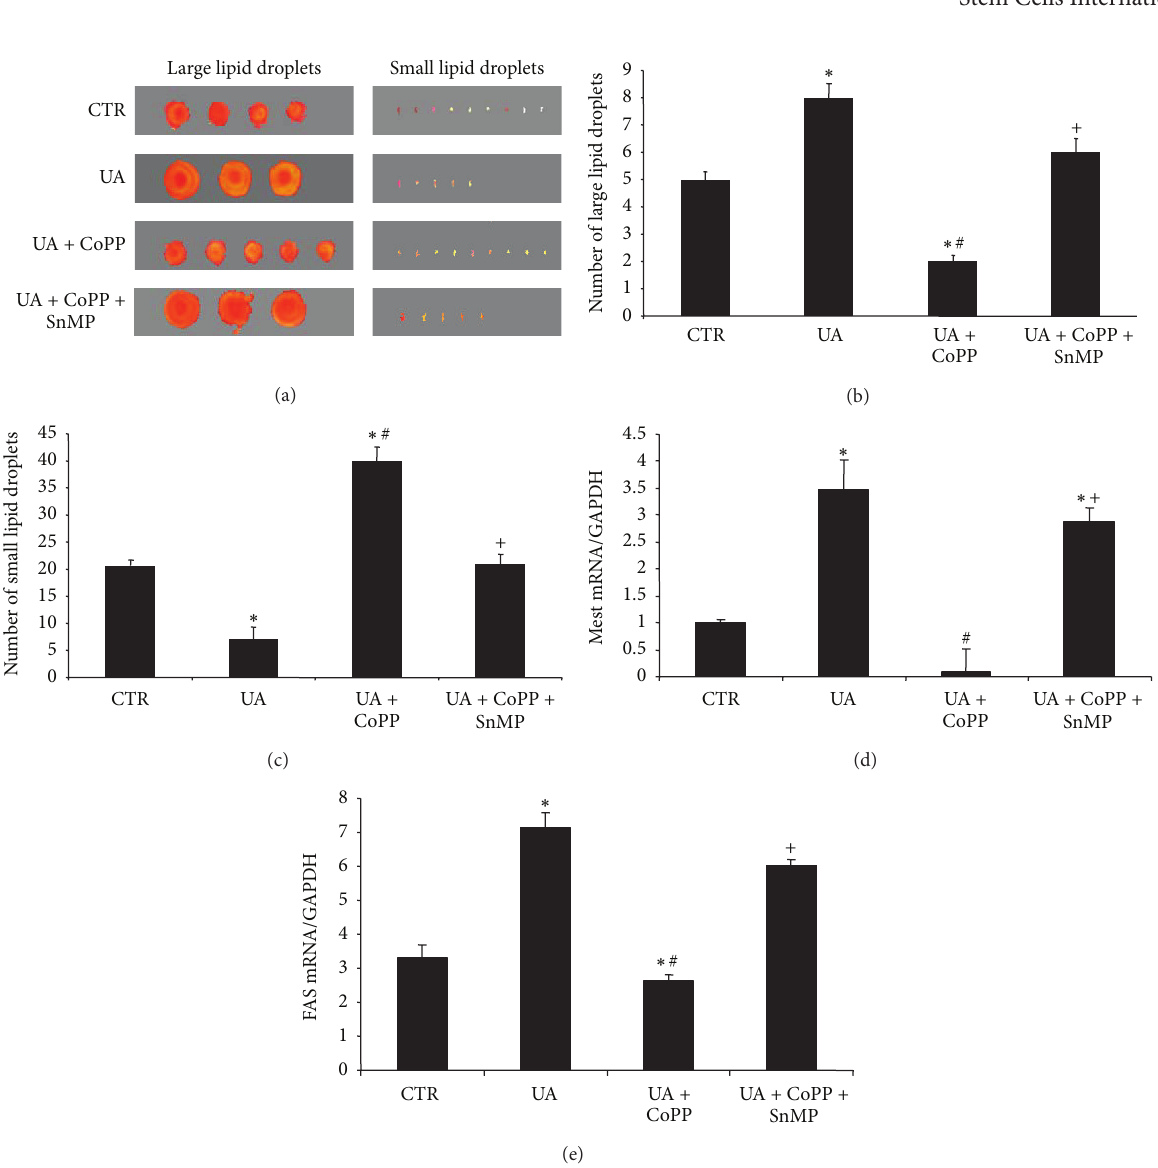
Figure 4: (a–c) Number of large and small lipid droplets from Oil Red O stained MSCs with 5 mg/dL uric acid with or without CoPP, in the presence or absence of SnMP; magnifications: 40x ( 𝑛 = 3 ). A representative section for each group is shown. Values represent means ± SEM of five independent treatments. ∗ 𝑝 < 0.05 versus CTR; # 𝑝 < 0.05 versus UA; and + 𝑝 < 0.05 versus UA + CoPP. (d) Real-time PCR of Mest. (e) and (d) Real-time PCR of FAS expression in MSCs treated with uric acid with or without CoPP, in the presence or absence of SnMP. Values represent means ± SEM of five independent treatments. ∗ 𝑝 < 0.05 versus CTR; # 𝑝 < 0.05 versus UA; and + 𝑝 < 0.05 versus UA +